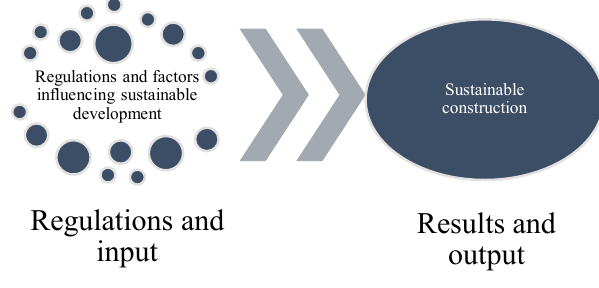
Fig. 1. The model of interconnection between regulations and factors